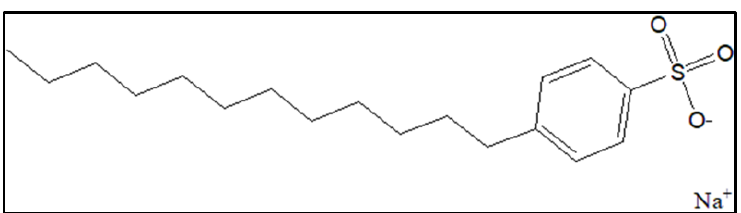
Figure 1. SDBS molecular structure.